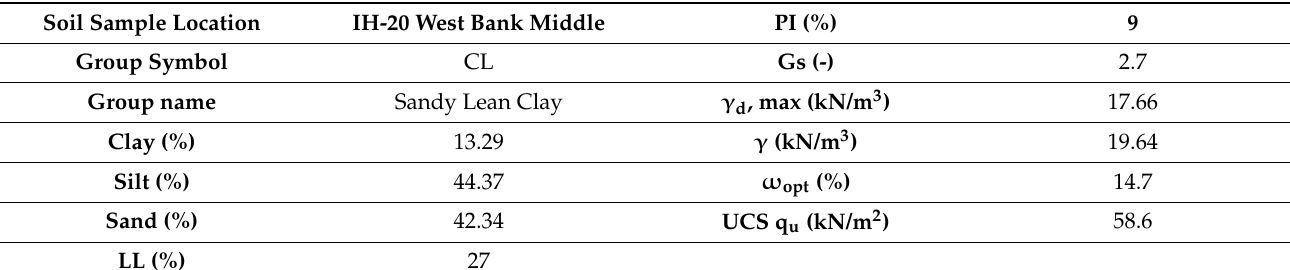
Table 1. Summary of laboratory test